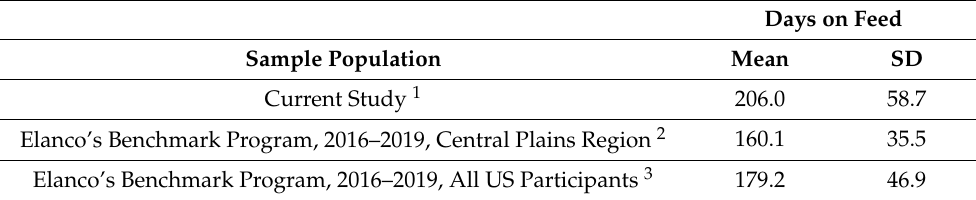
Table 3. Days on feed (DOF) from the current study and historical data from an industry bench- marking program. Historical data presented represents information collected from August through October for the years 2016 through 2019.